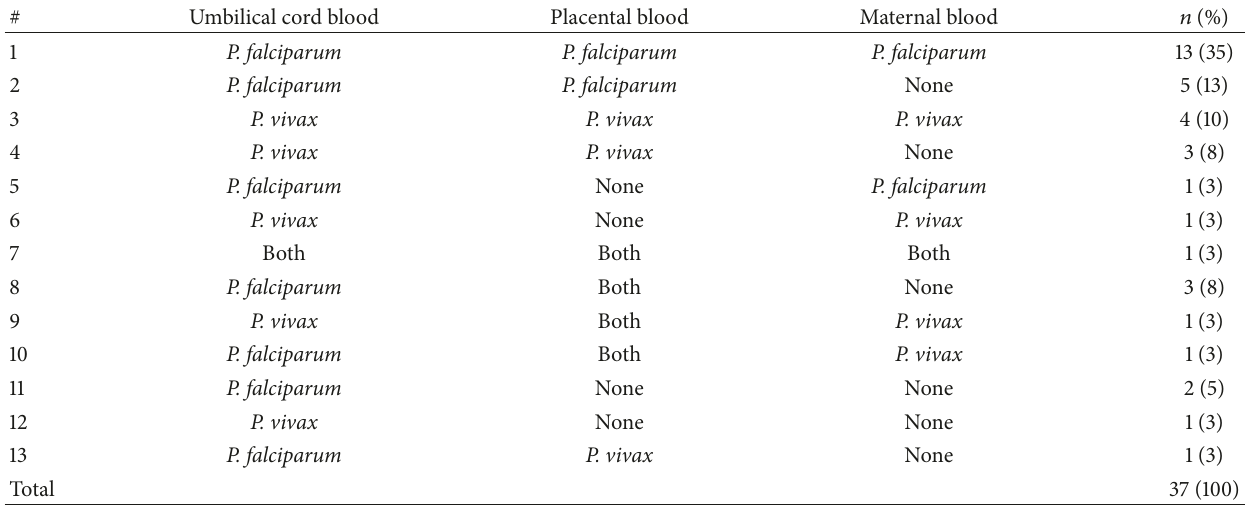
(b) In three compartments